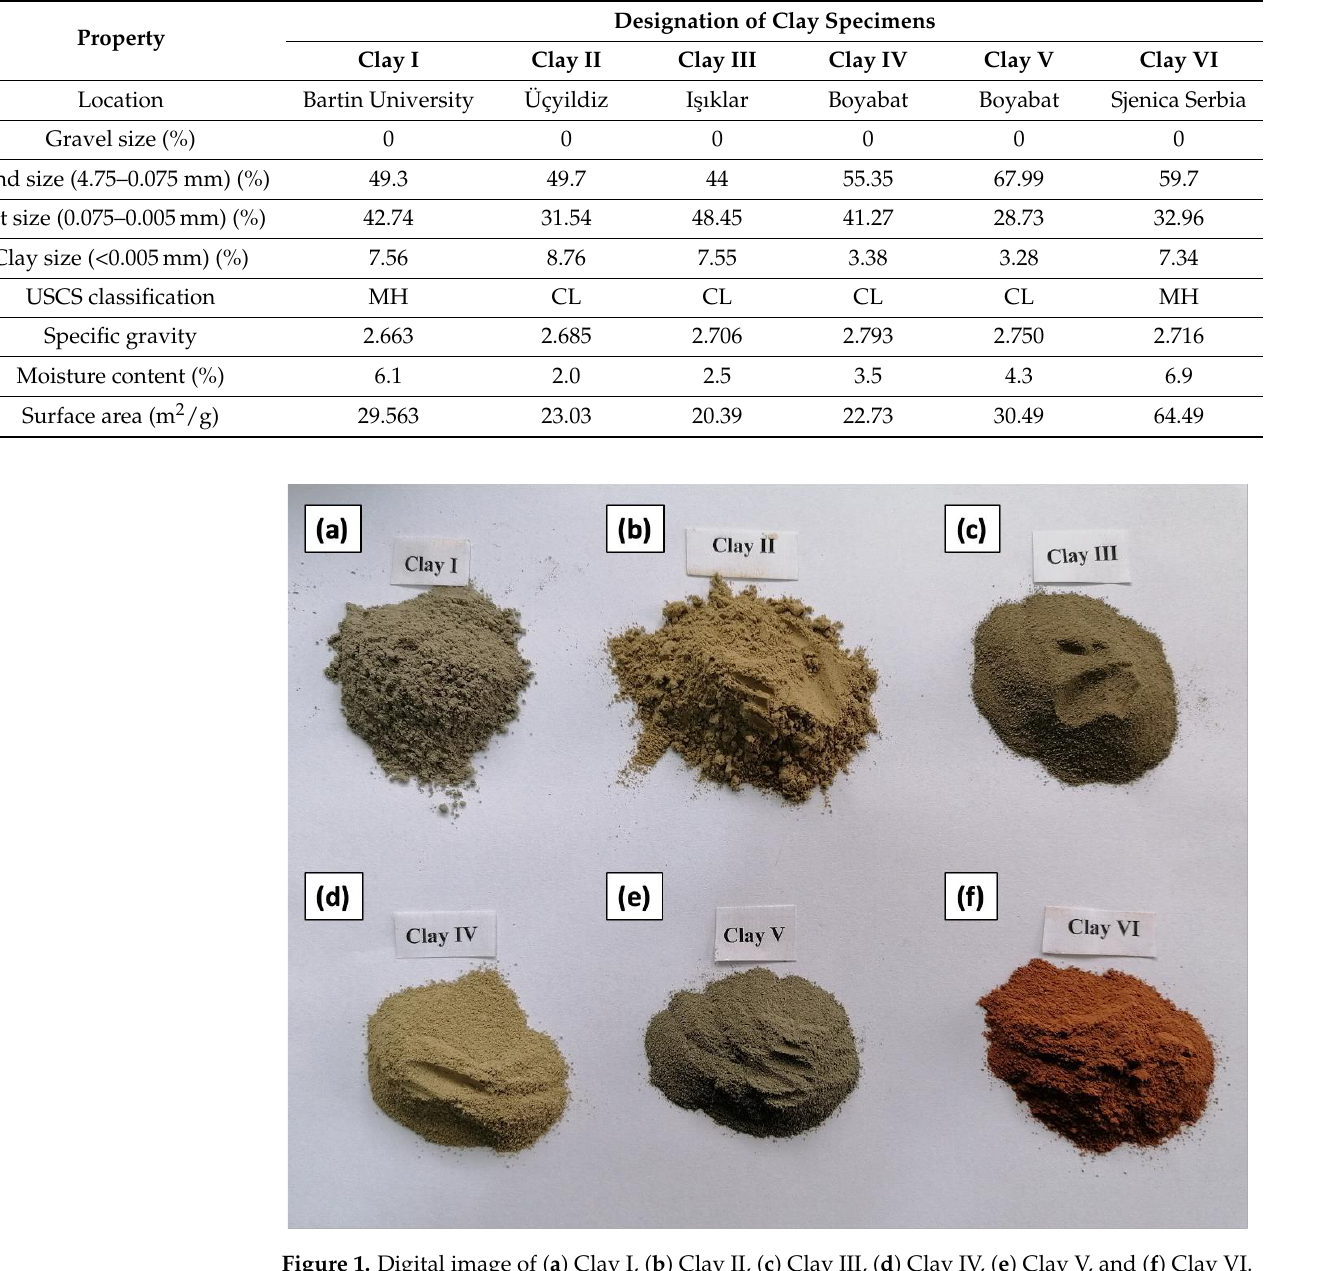
Figure 1. Digital image of ( a ) Clay I, ( b ) Clay II, ( c ) Clay III, ( d ) Clay IV, ( e ) Clay V, and ( f ) Clay VI.